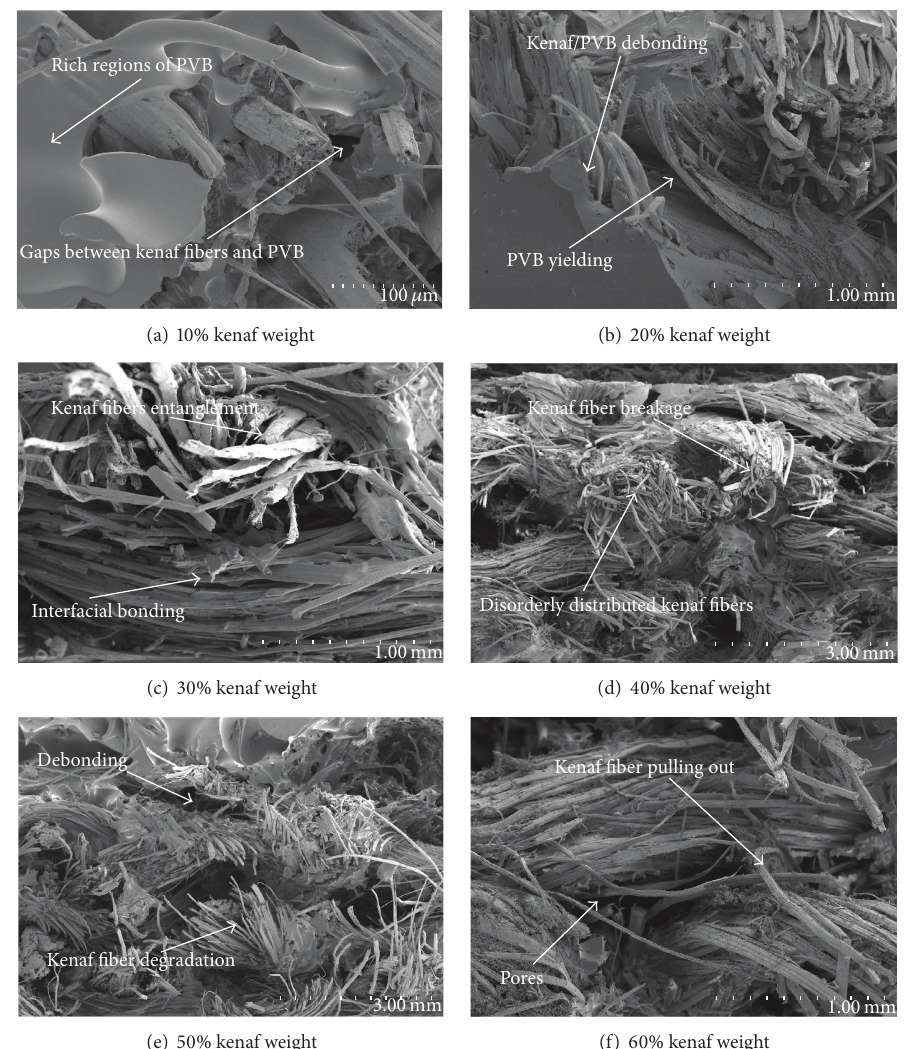
Figure 12: The SEM micrographs of the Charpy impact failure surfaces of kenaf/PVB film